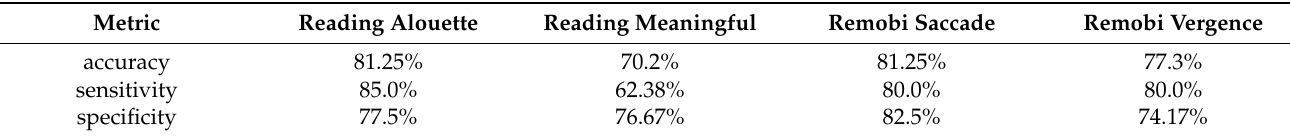
Table 3. Logistic regression scores for Analysis